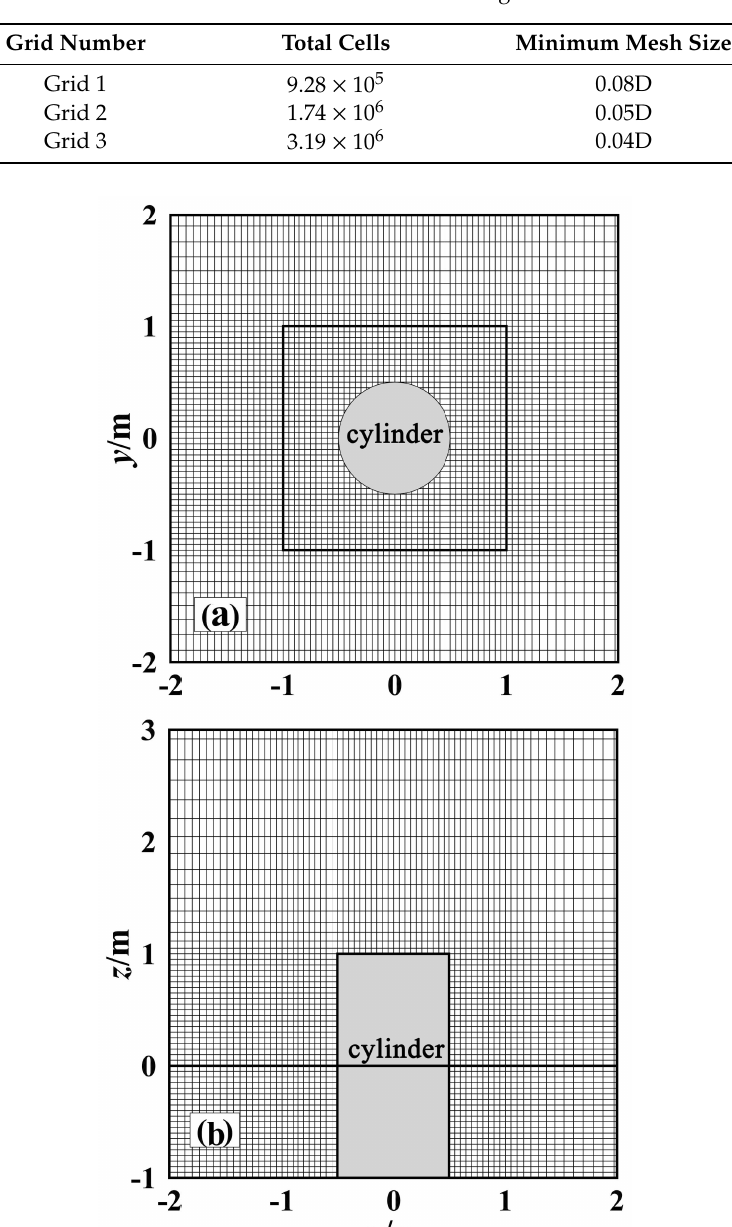
Figure 6. The sketch view of the grids near the cylinder (Case 2), ( a ) top view; ( b ) side